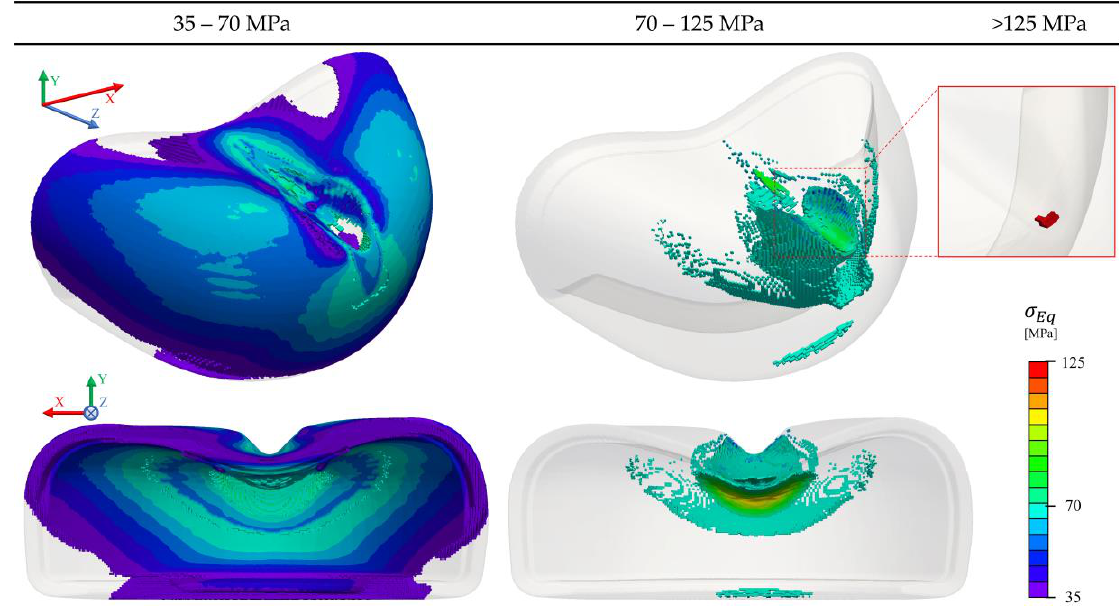
Figure 20. Von Misses stress distribution with applied threshold of ( left ) 35–70 MPa, ( middle ) 70–125 MPa, and ( right ) cells with maximum stress, for the impact